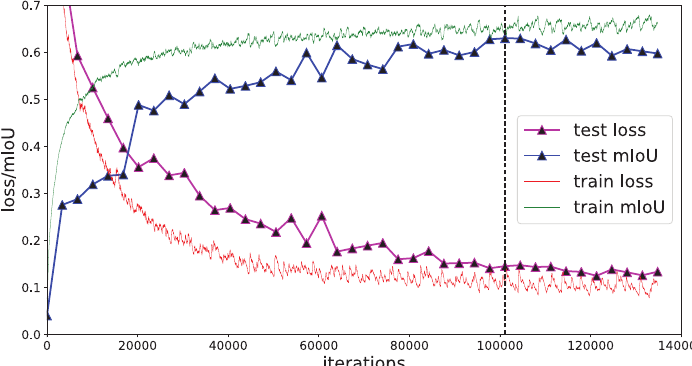
Figure 12. Training and testing curves of TerrainNet. The black vertical dotted line indicates the number of iterations corresponding to the best epoch